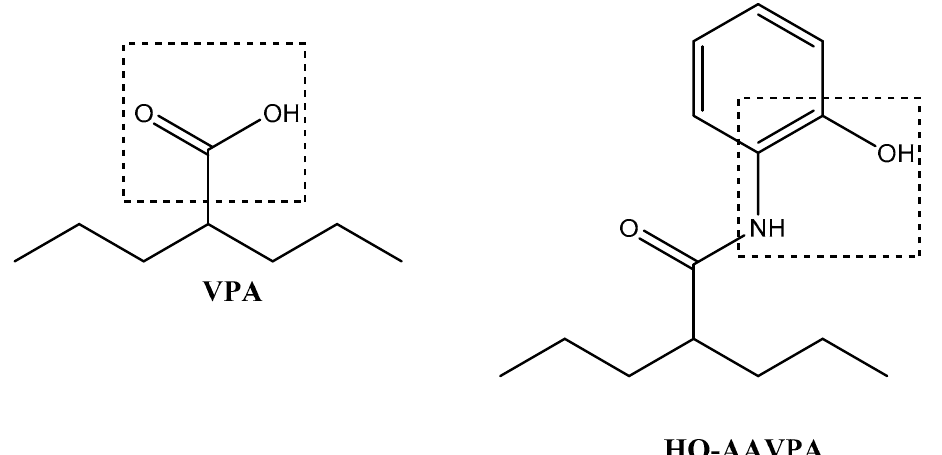
Scheme 1. Chemical structures of valproic acid and HO-AAVPA